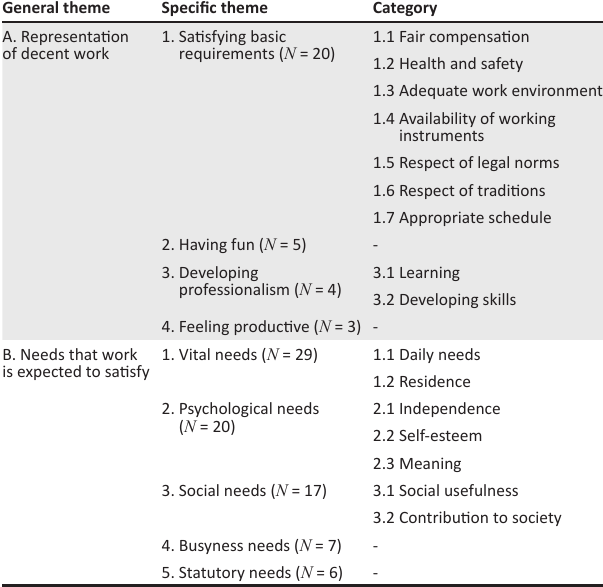
TABLE 1: Overview of themes and categories. General theme Specific theme